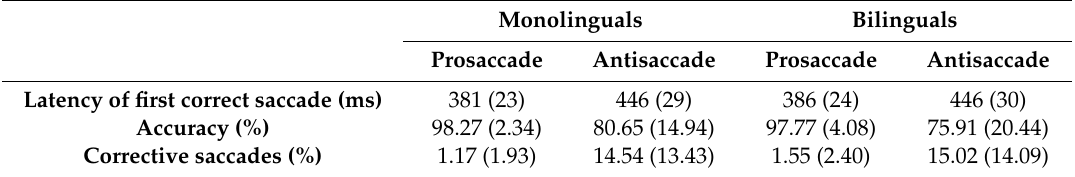
Table 3. Group means of antisaccade task performance (standard deviations in